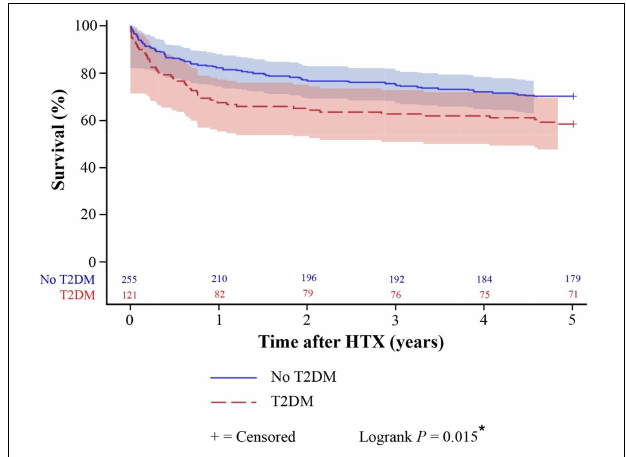
FIGURE 1 | Five-year post-transplant survival of patients with and without T2DM at HTX (Kaplan–Meier estimator). Patients with T2DM at HTX had a significantly worse 5-year post-transplant survival in the Kaplan–Meier survival analysis (58.7%) compared to patients without T2DM at HTX (70.2%, P = 0.015). HTX, heart transplantation; T2DM, type 2 diabetes mellitus; *, statistically significant ( P <